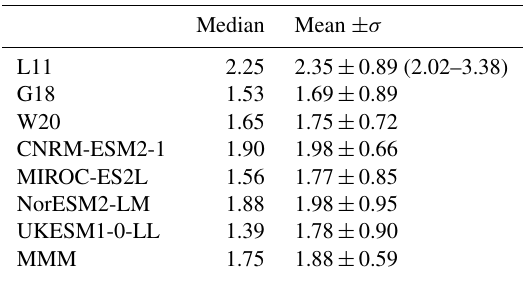
Table 3. Area-weighted statistics: median, mean, and spatial stan- dard deviation of annual DMS surface ocean concentration (nM) shown in Fig. 1. For the L11 climatology, means of the minimum and maximum values estimated by the authors are shown in brack-